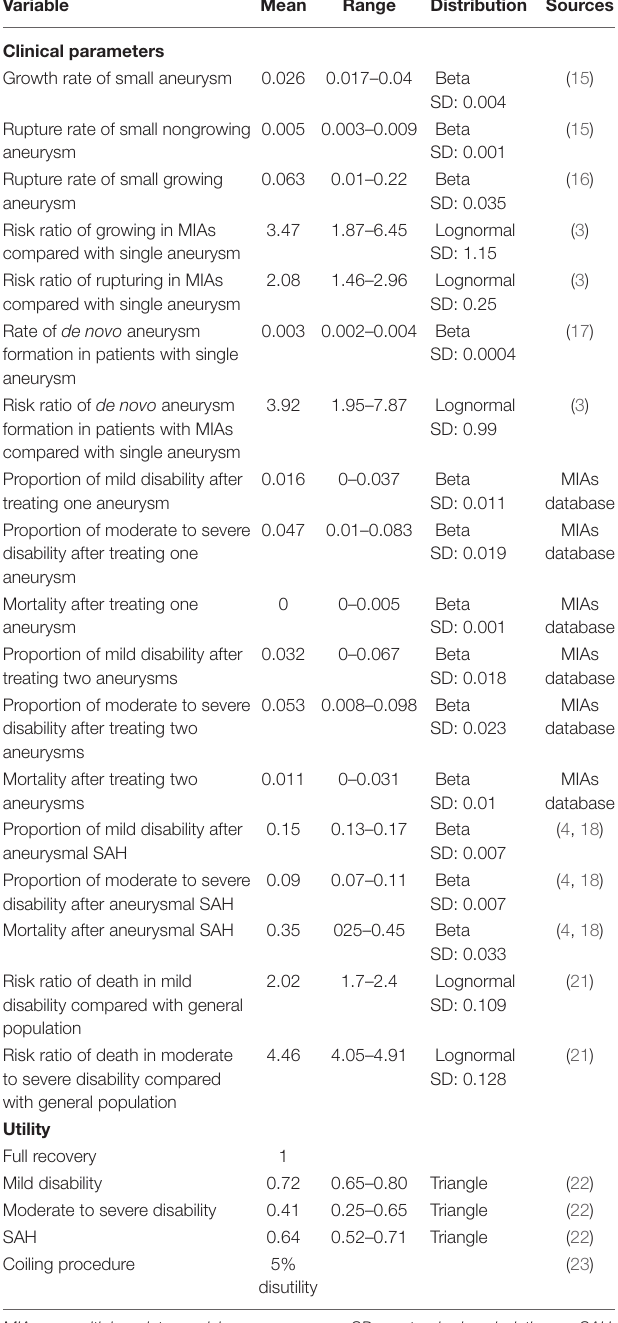
TABLE 1 | Input parameters of the decision analytic